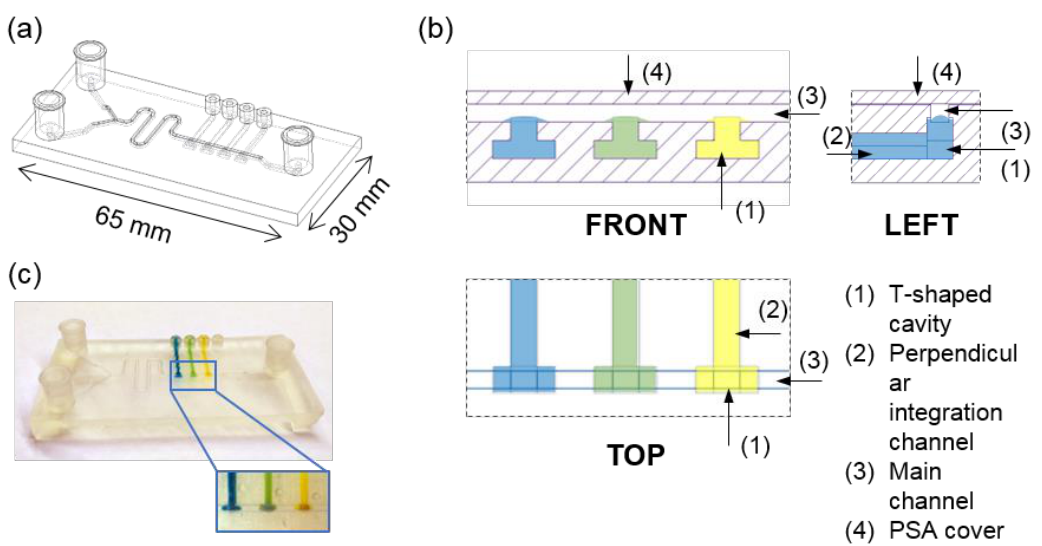
Figure 1. ( a ) 3D model representation of the microfluidic device. Internal channels and cavities are shown as hidden lines, drawn with a lighter greyish black, while external channels are represented with a darker black. ( b ) Representation of the T-shaped sensing zones (front, left and top views). ( c ) Picture of the 3D printed device with integrated pH-sensing ionogels (from left to right, bromocresol green (BG), bromocresol purple (BP), phenol red (PR), and phenolphtalein (Ph)).